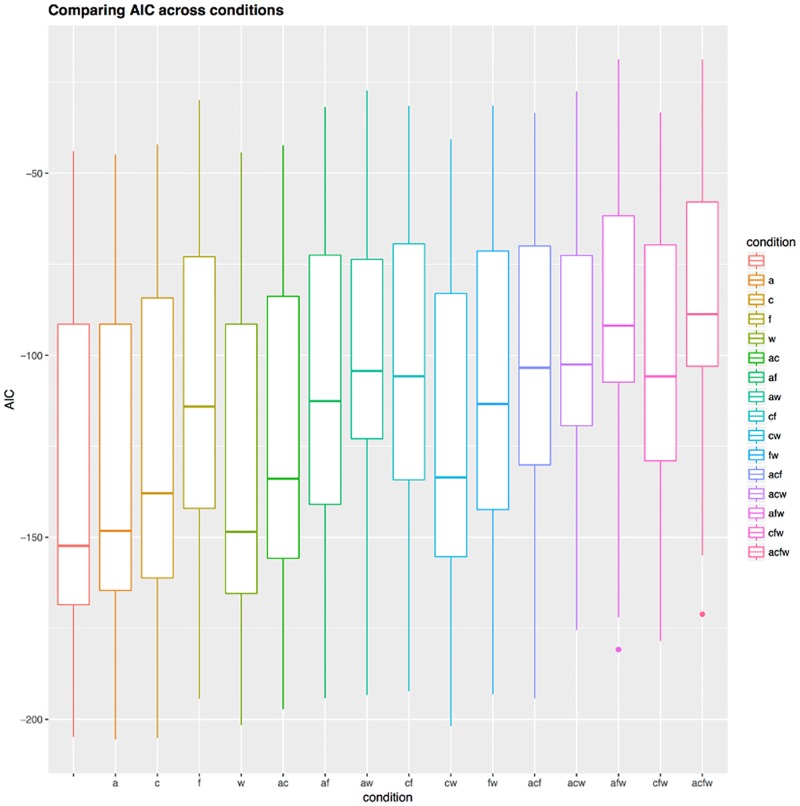
Comparing the AIC across conditions.The distribution of Akaike’s Information Criterion (AIC) across conditions (identified both on the horizontal axis and by color) represented as boxplots; lower AIC values are preferred.